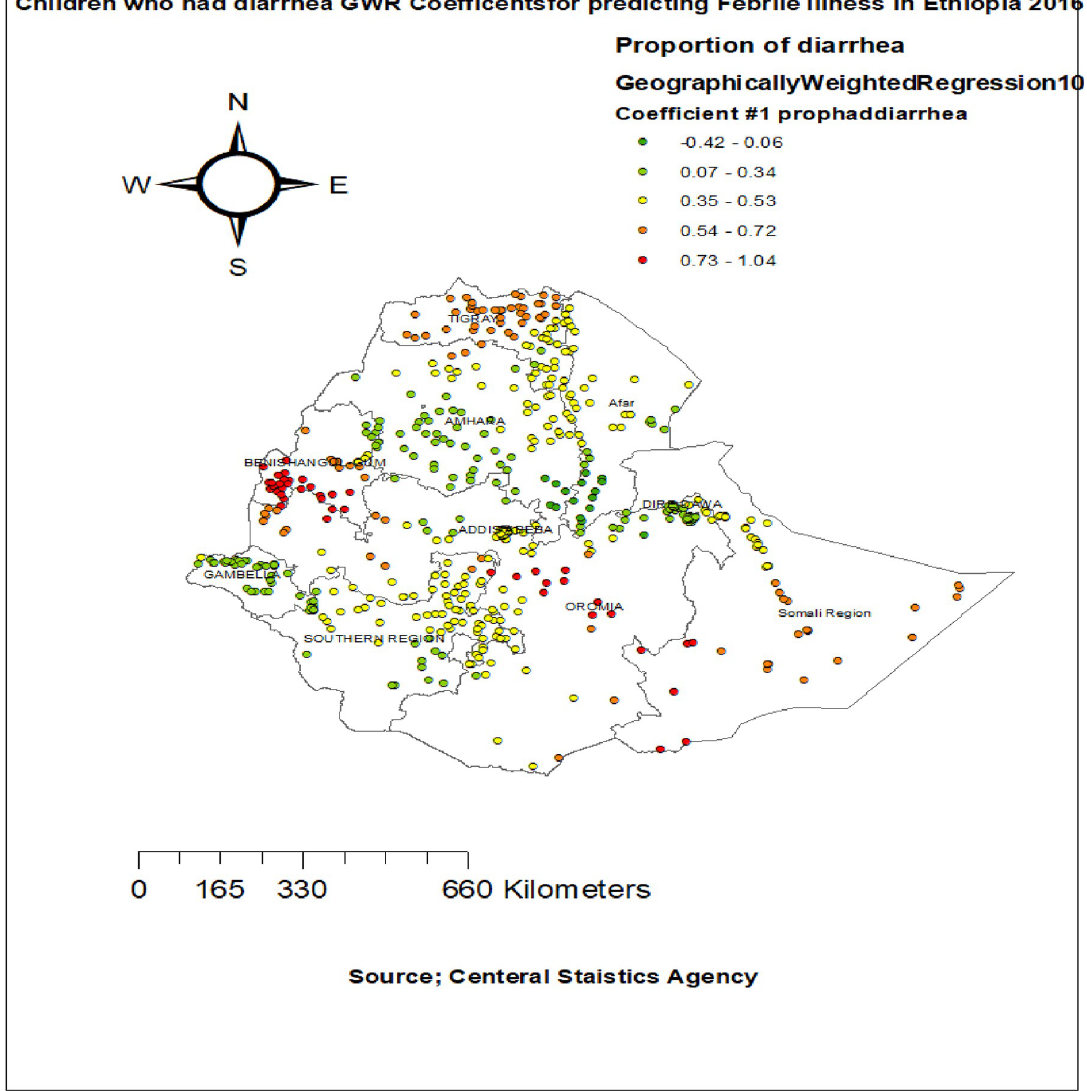
Fig 5. Children who had diarrhea GWR coefficients for predicting febrile illness among under five children in Ethiopia, 2016.